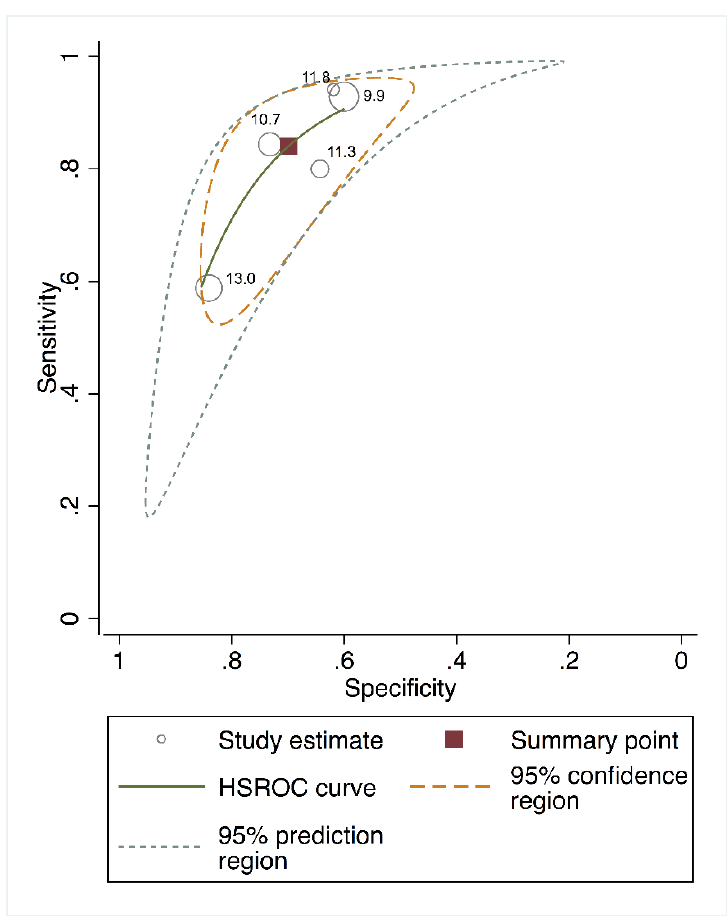
Figure 4. HSROC curve for cfPWV predicting cardiovascular mortality.